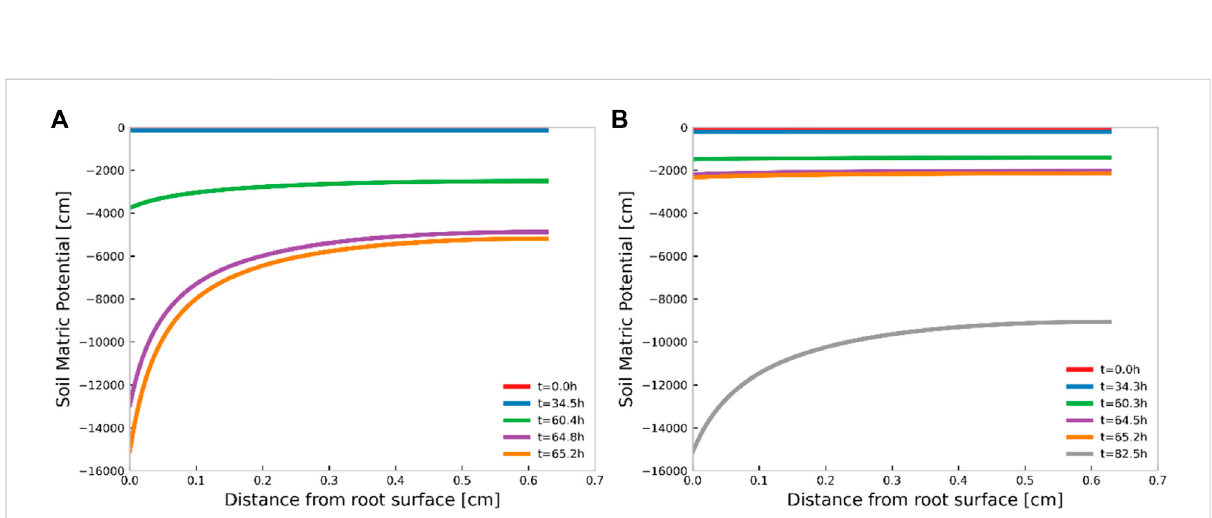
FIGURE 4 Simulated pro fi les of the matric potential plotted as a function of distance from root surface at different time steps for the case of sandy soil treated with (B) and without (A) an addition of 1% Aerosil300. A steady rate root water uptake is simulated till soil matric potential reached a critical value corresponding to PWP at the root surface in the soil. With the addition of 1% Aerosil300, root water extraction induced soil drying cycle lasted 17.3 h longer [t = 82.5 h, (B) ] than for the